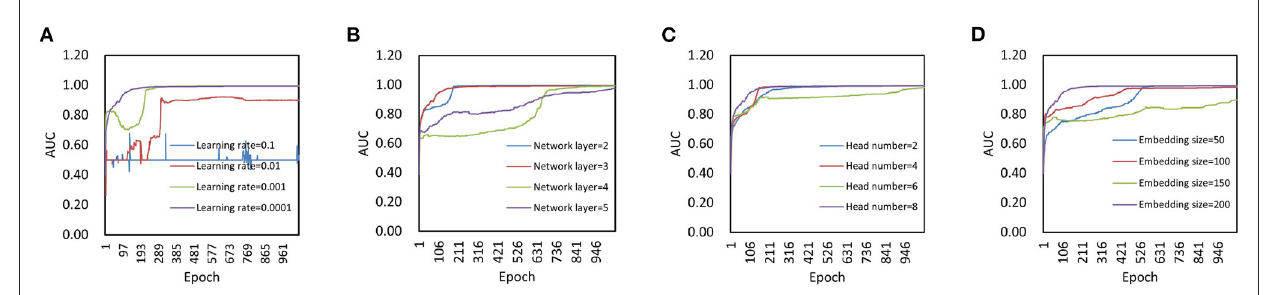
FIGURE2 Parameter analysis. (A) Effect of learning rate on model performance. (B) Effect of network layer on model performance. (C) Effect of head number on model performance. (D) Effect of embedding size on model performance.